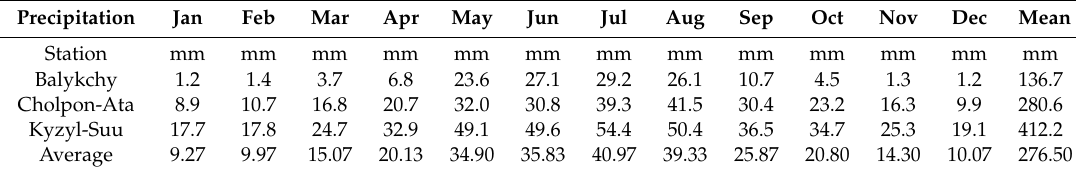
Table 1. Monthly average precipitation for the three studied stations in the Lake Issyk-Kul basin (1951–2012).